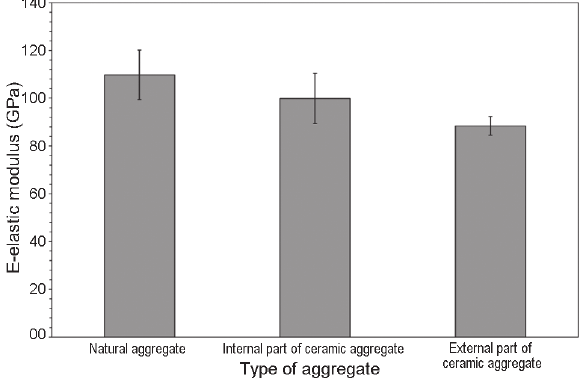
Fig. 6. Elastic modulus of coarse